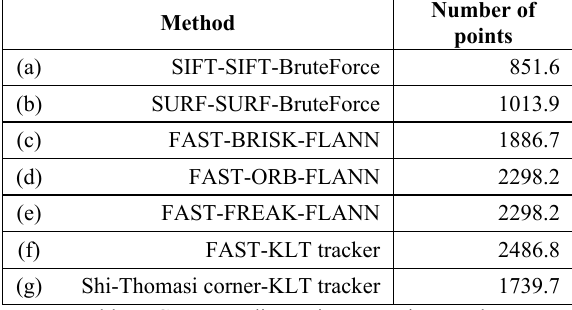
Table 7. Corresponding point extraction results